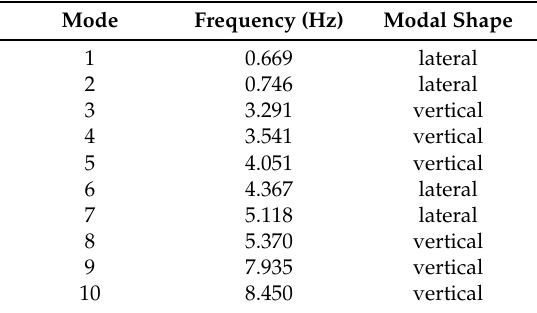
Table 3. The first ten natural frequencies of the bridge.